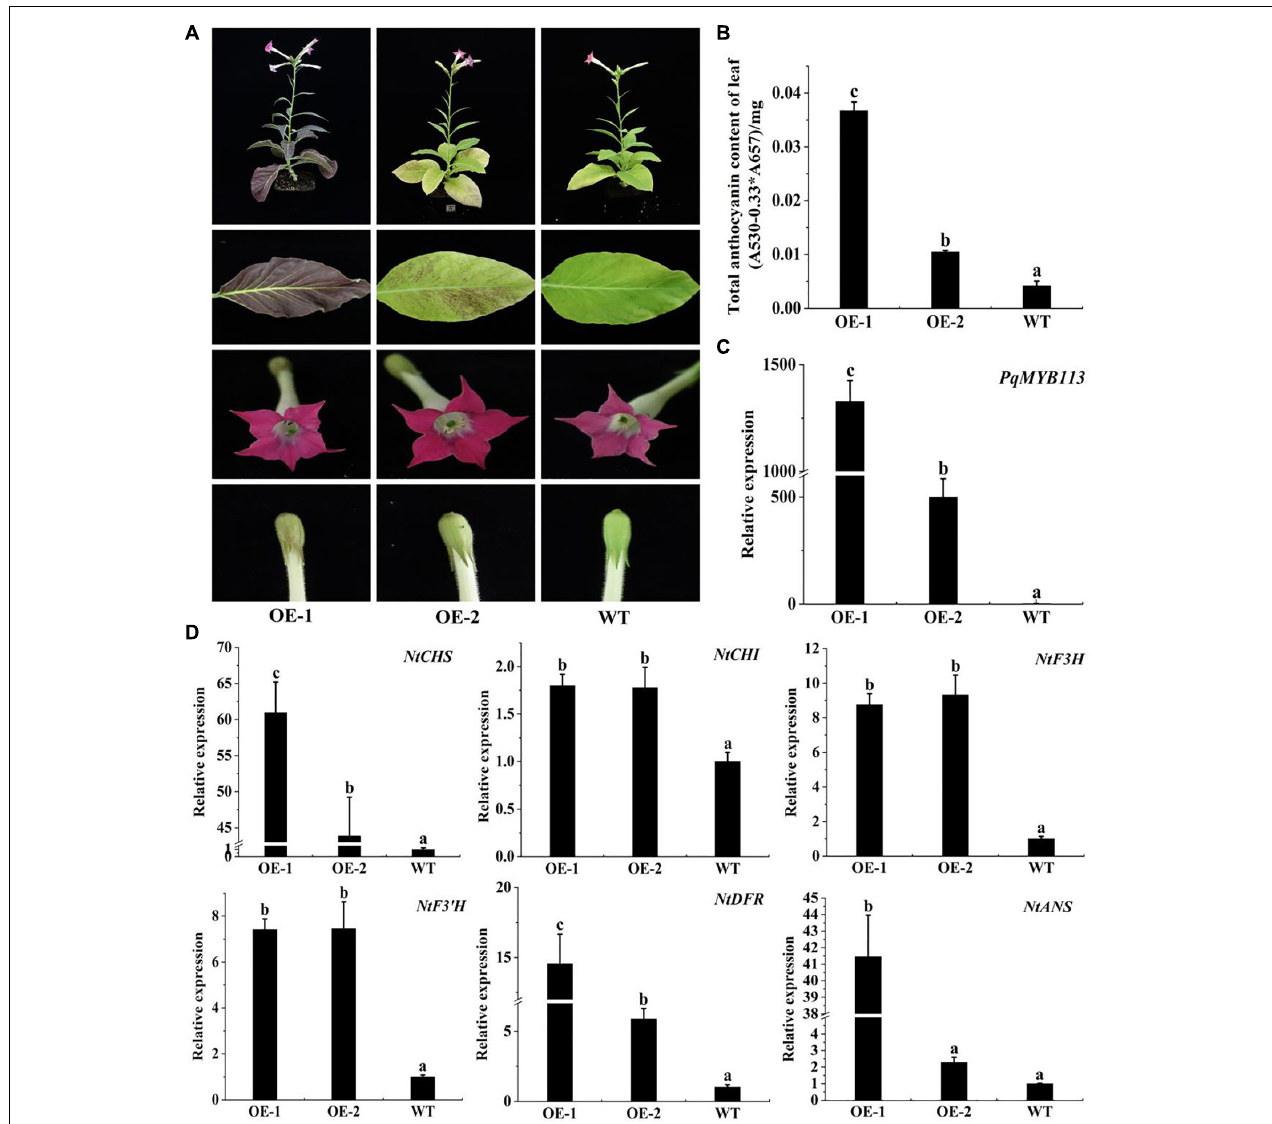
FIGURE 7 | The phenotype and the effect of PqMYB113 overexpression in transgenic tobacco. (A) . The phenotype of OE-1 and OE-2 in comparison to WT. (B) The anthocyanin content in leaves. (C) The expression level of the PqMYB113 gene in leaves. (D) The expression level of anthocyanin biosynthesis structure genes. a, b, and c indicate significant differences at the P ≤ 0.05 level by Duncan’s